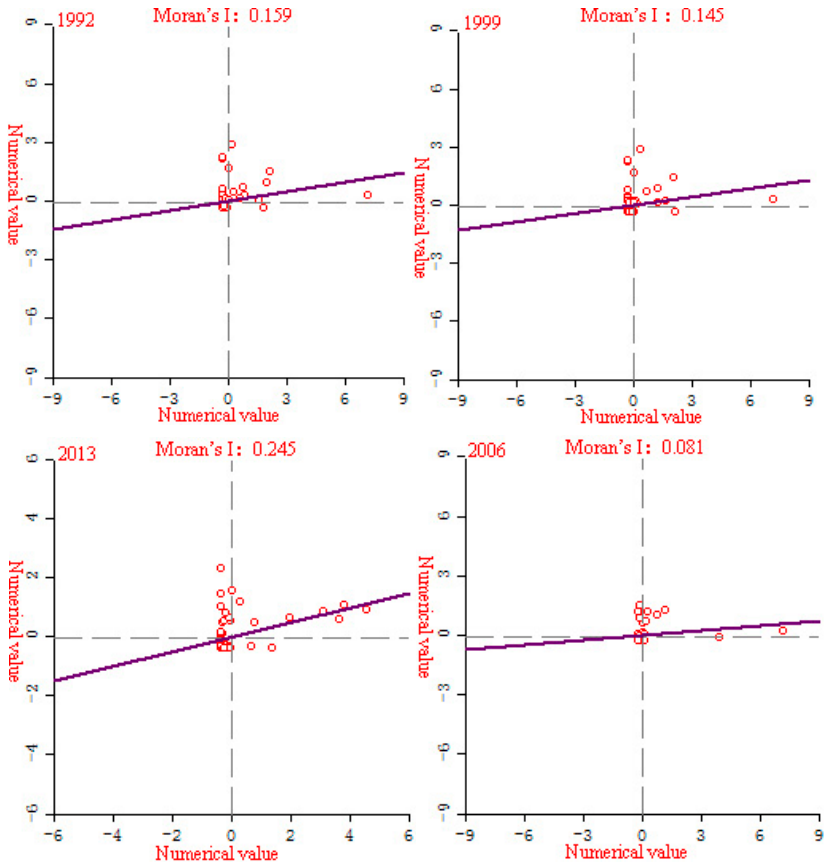
Figure 14. EPC partial Moran’slocal Moran’s I index scatter plot of YREB’s three major urban agglomerations in 1992–2013.